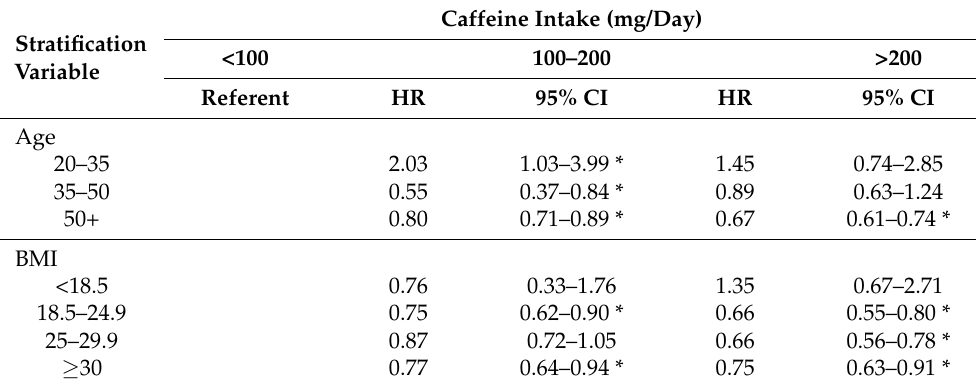
Table 3. Caffeine Intake and All-Cause Mortality by Age and BMI Groups.